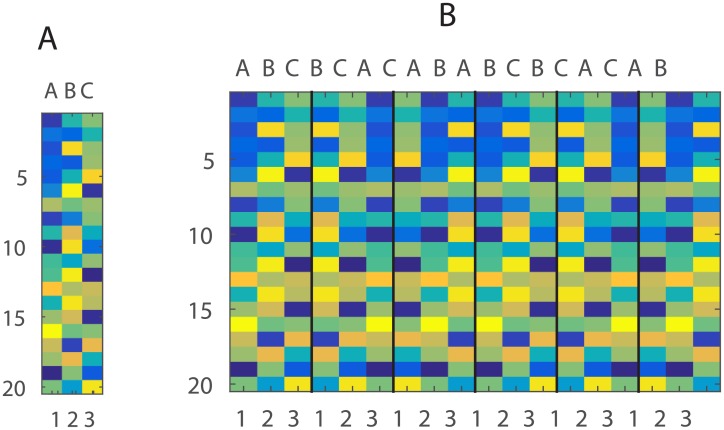
Simulated responses to items.(A) Item patterns over 20 voxels. (B) Six sequences as permutations of three items. Item codes are displayed on the top of x-axis, position codes at the bottom.